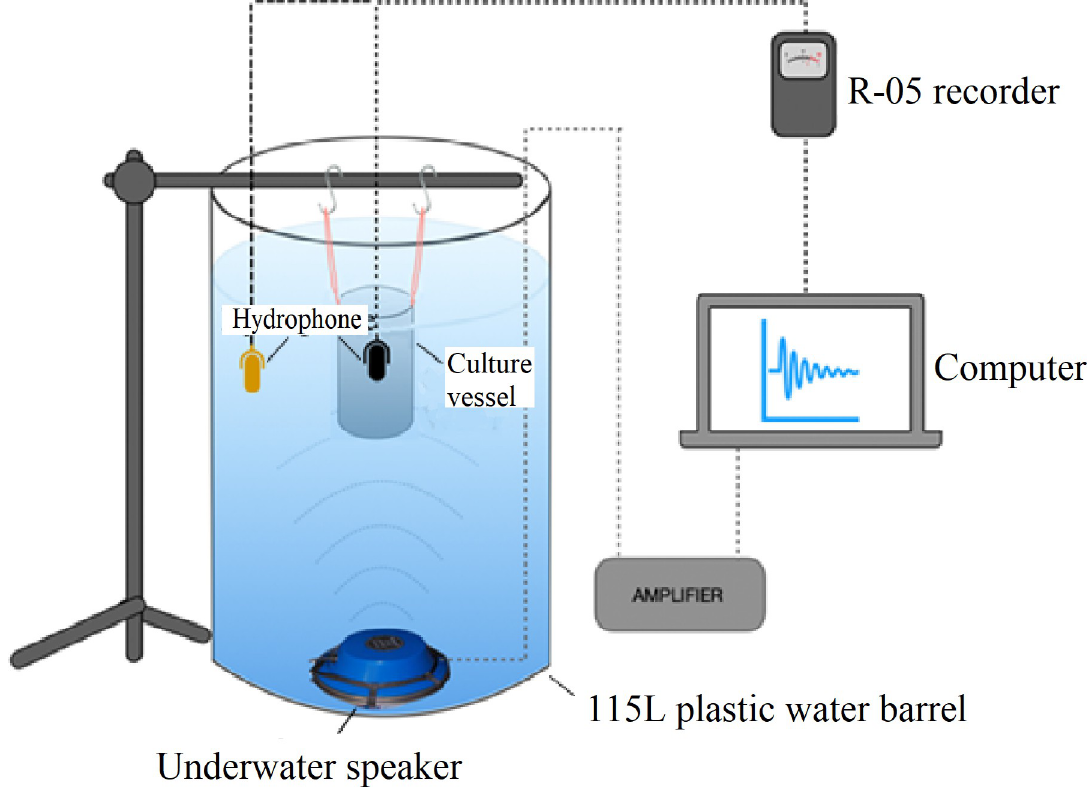
Fig 1. Set-up for sound transmission testing. Culture vessels were suspended by rubber bands from a microphone stand to acoustically isolate the vessel and submerged underwater in a 115 L plastic barrel filled with freshwater. Sound source files were played from a computer, amplified, then used to drive an underwater speaker at the bottom of the barrel. Transmitted sound within the barrel was measured with hydrophones and R-05 sound recorder, then processed in MATLAB (S1 Appendix). During sound transmission testing, a hydrophone was suspended within the culture vessel, and another in the barrel to obtain baseline values. Experiments were performed in an anechoic chamber to minimize extraneous sources of sound. Multiple barrels (not shown) were contained within the same anechoic